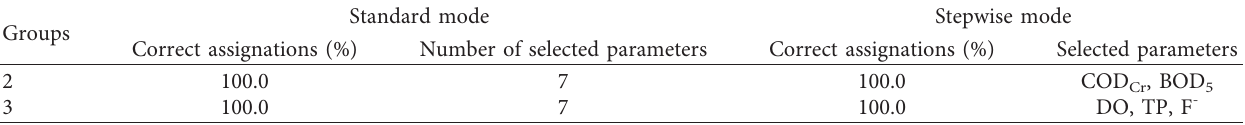
Table 3: Spatial discriminant analysis of pollutants in the XSWR.